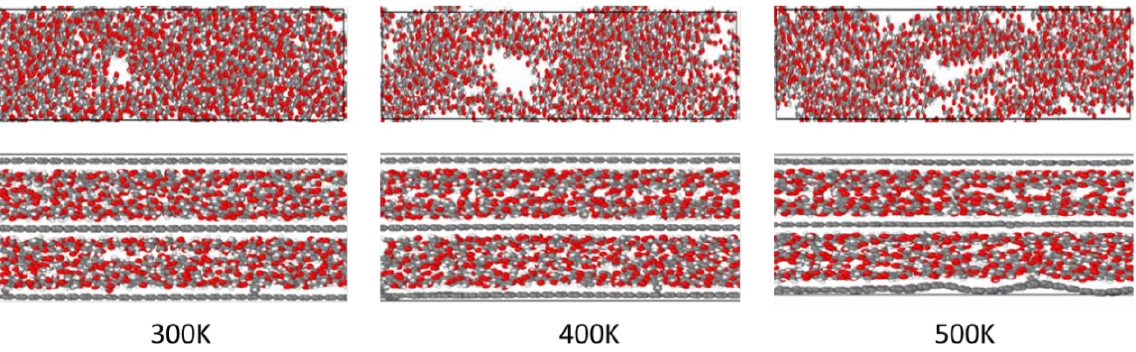
Figure 4. Visual representation of tensile process with the increasing temperature (upper atomic model is pristine CNCs and the lower atomic model is CNCs-graphene layered composite)